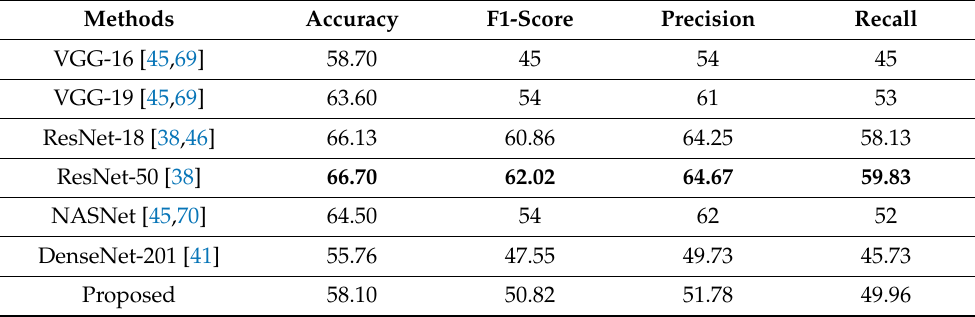
Table 11. Performance comparisons of state-of-the-art methods and the proposed approach without data augmentation. Averages from a 10-fold cross-validation are shown (unit: %).